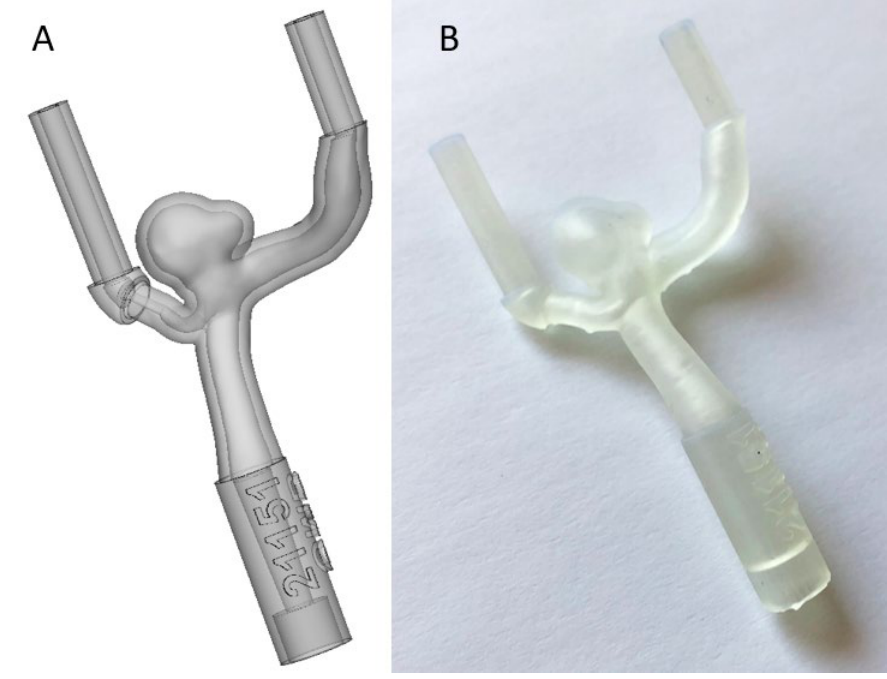
Figure 2. The result of the 3D segmentation ( A ) and the 3D final print ( B ).